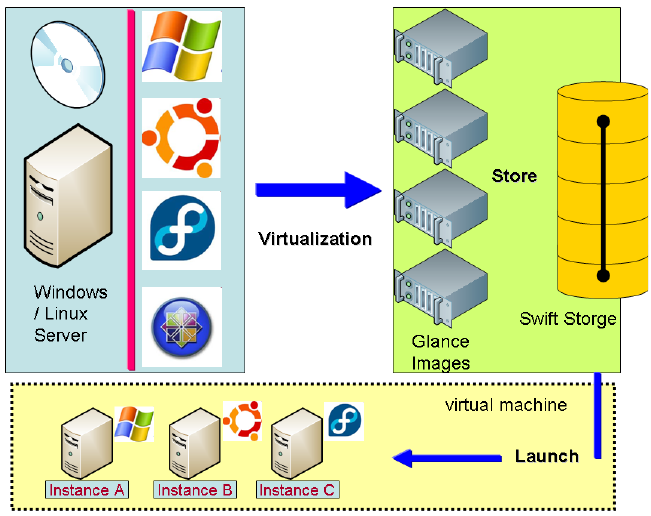
Figure 12. Glance Image